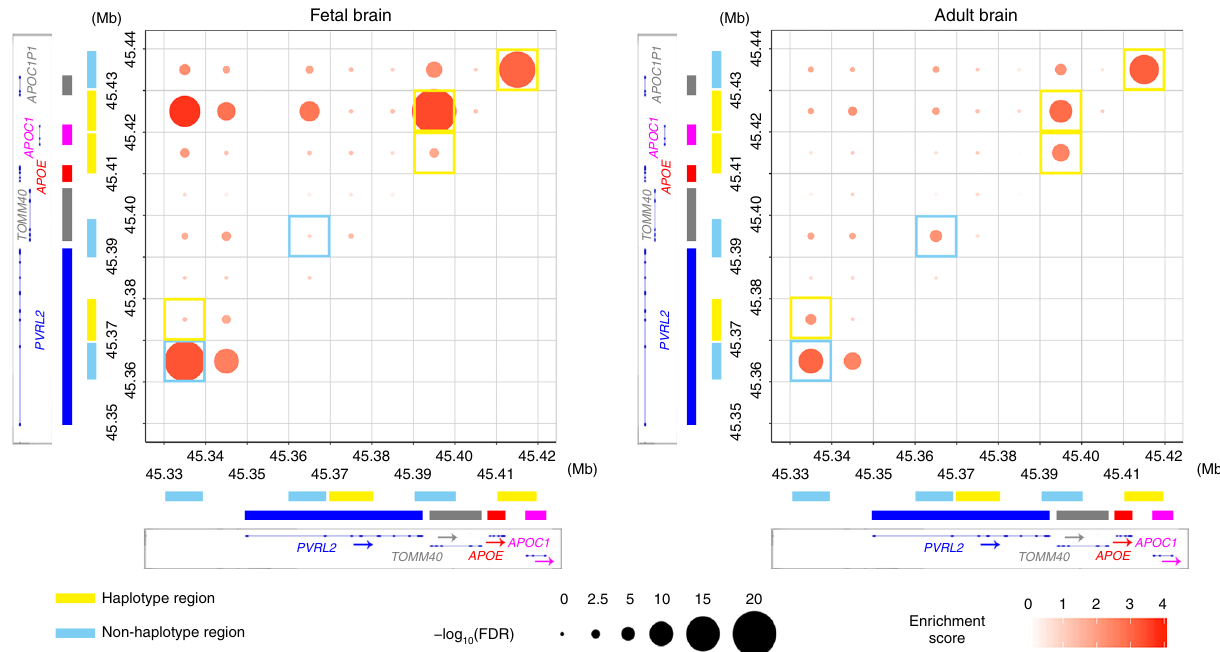
Fig. 6 Chromatin interaction analysis showing the physical interactions between the PVRL2 , APOE , and APOC1 regions in fetal and adult human brain tissues. Chromatin interaction events were measured by Hi-C assay. Dot plots show the physical interaction events in and near the APOE region (19:45,330 – 45,440 kb) with a bin size of 10 kb. X and y -axes denote the genomic coordinates, with the corresponding gene body marked on the side (blue, red, and pink bars denote the gene body regions of PVRL2 , APOE , and APOC1 , respectively). Genomic regions that cover the risk haplotypes are denoted in yellow, and haplotype regions are denoted in cyan. The color intensity of dots represents the interaction strength of the corresponding pair of genomic regions (the enrichment score was calculated by dividing the observed number of contact events by the expected number of contact events; dark colors indicate strong interactions). Dot size corresponds to statistical signi fi cance ( − log 10 of the FDR); larger dots indicate higher con fi dence of the observed interaction. Hi-C results obtained from fetal (left panel) and adult (right panel) brain are shown. Interaction hotspots located in the regions that cover risk haplotypes and non-haplotype regions are bordered by yellow and cyan, respectively. For both groups, three replicates were pooled for the analysis. Mb megabases in GRCh37 coordinates, FDR false discovery